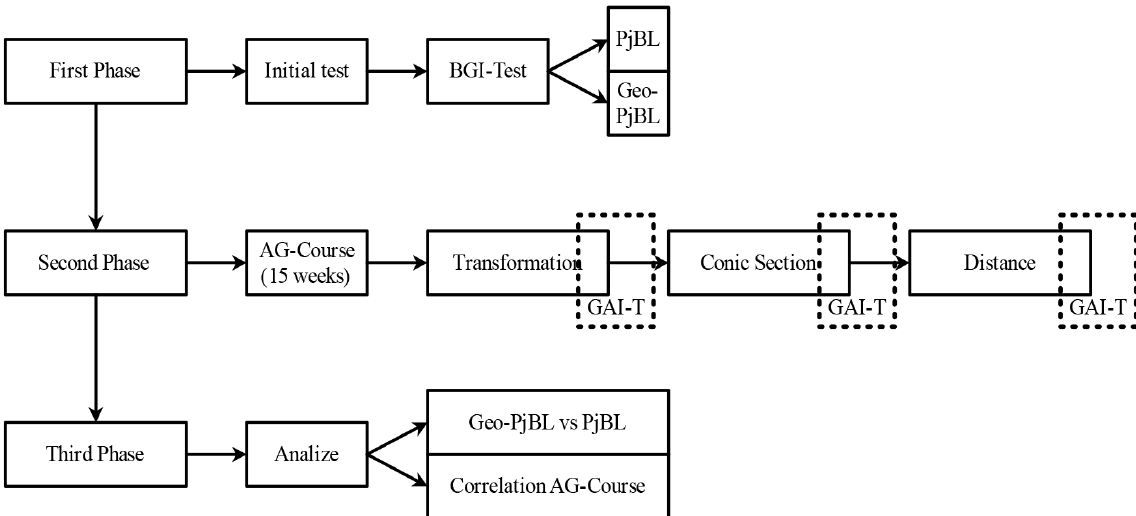
Figure 2. Research design